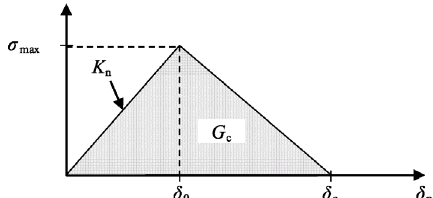
Fig. 8 Bilinear traction  separation law for the cohesive